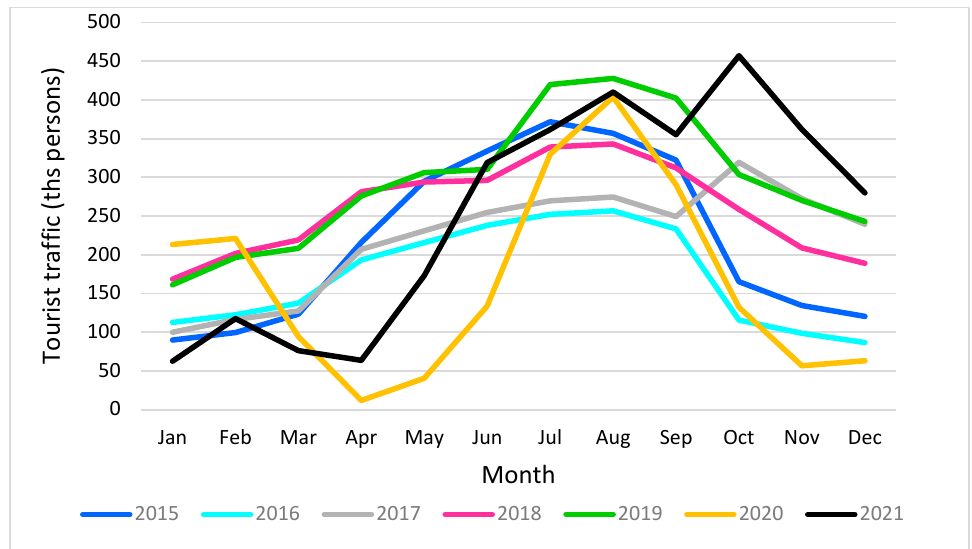
Figure 4. Intensity of tourist traffic changes (2015–2021) in the Gda ń sk agglomeration. Source: own study.